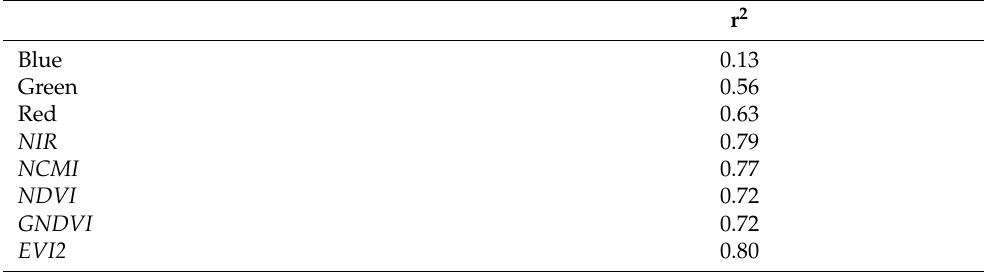
Table 4. Coefficient of determination (r 2 ) between the data of Sentinel-2 and Planet at 10 m spatial resolution for each band and VI at 66 DAS ( p < 0.01 for each band and VI except for the blue).